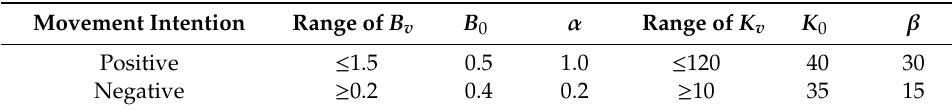
( b ) Figure 9. Measured data. ( a ) Motion trajectory of the hip joint (black line) and knee joint (red line). ( b ) Measured interaction torque of the knee joint. Figure 10. The relationship between the angular displacement of the knee joint and standard interaction torque in the knee joint. Table 3. Results of the human-exoskeleton interaction measurement experiment. Subject Linear Equation baxy += a b H1 (male, 24 years old, weight/60 kg, height/1.70 m)